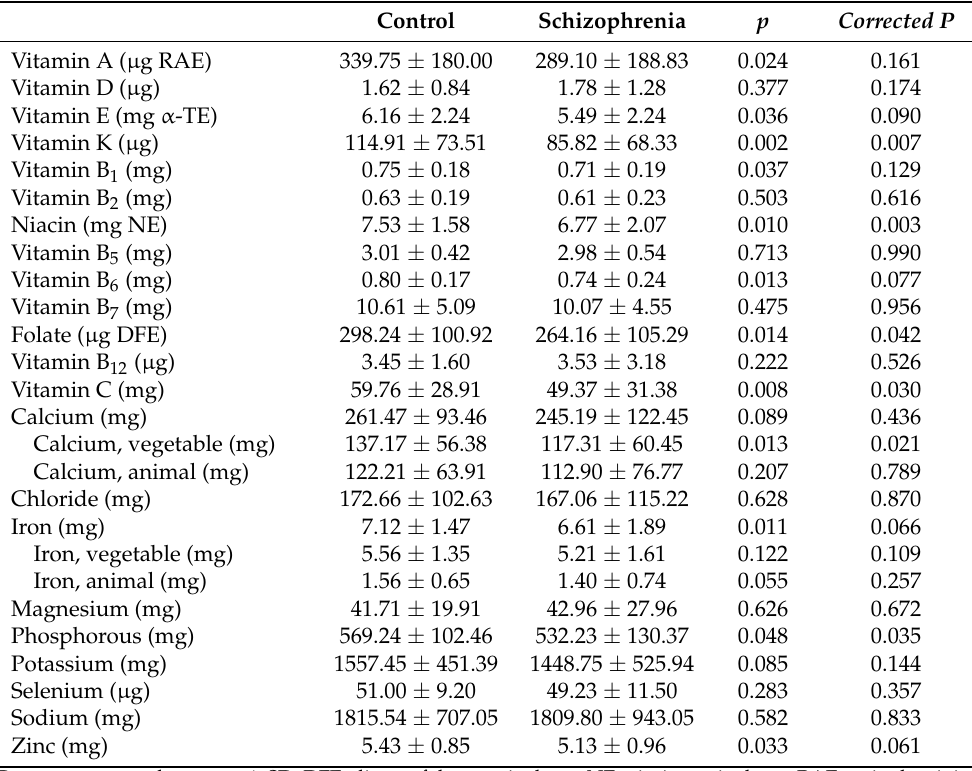
Table 4. Energy-adjusted dietary intakes (per 1000 kcal) of vitamins and minerals.